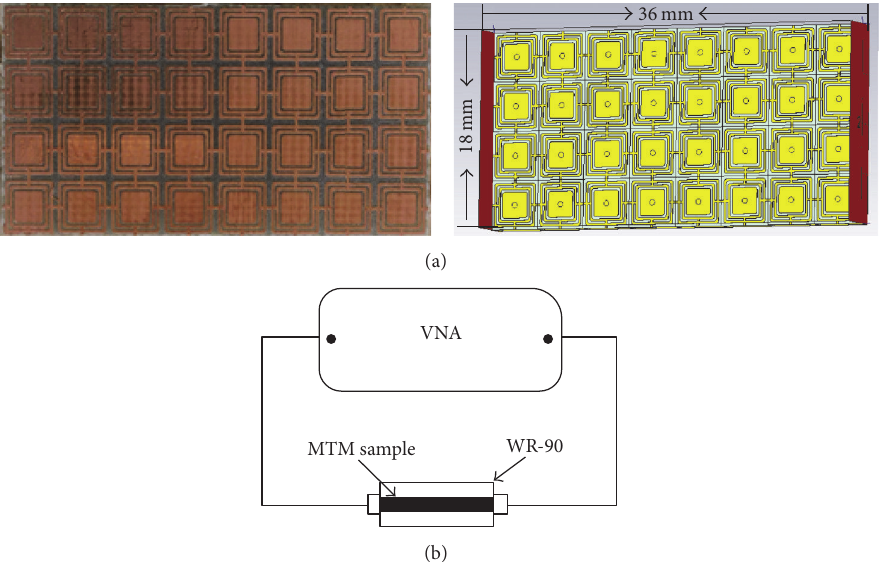
Figure 4: (a) The fabricated 4 × 8 arrangement sample; (b) experimental set-up schematic representation. VAN: vector network analyzer.